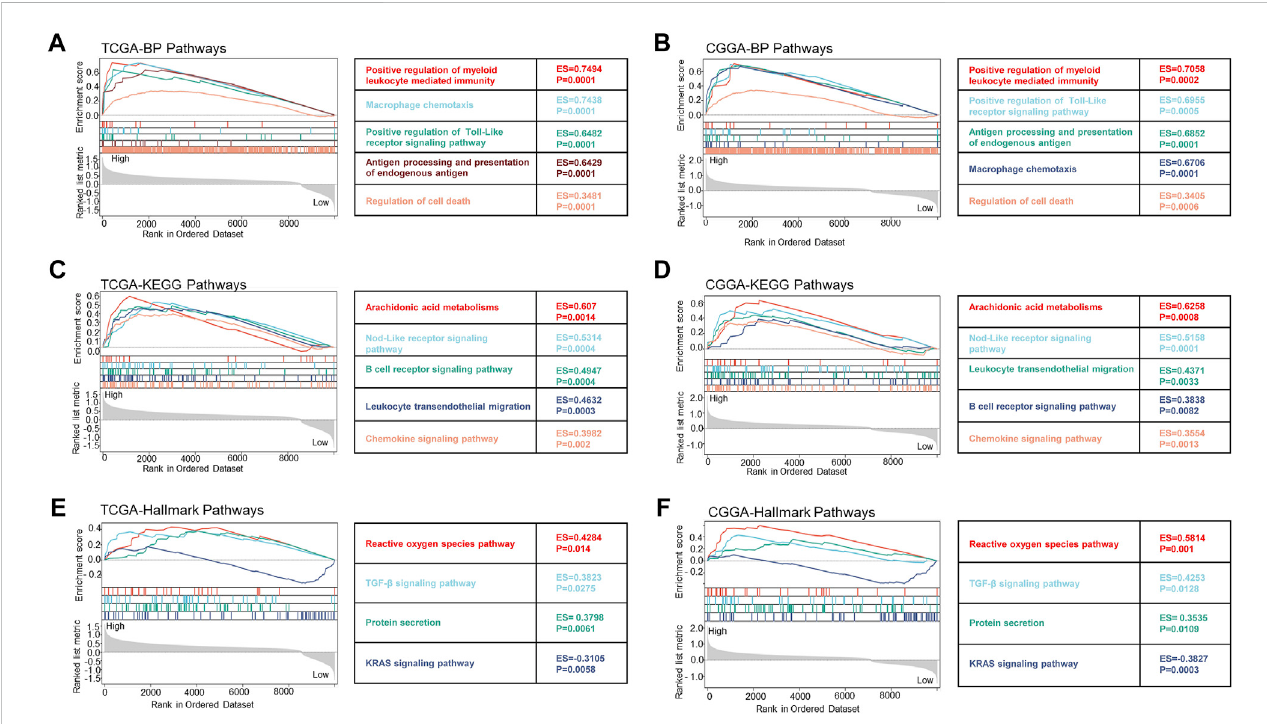
FIGURE 9 ThebiologicalfunctionofFDX1genewasshowninbiologicalprocess(BP)pathways,KEGGpathways,andHallmarkpathwaysinLGGaccordingtoTCGA and CGGA datasets. (A,B) Relationship between FDX1 expression and BP pathways. (C,D) Relationship between FDX1 expression and KEGG pathways. (E,F) Relationship between FDX1 expression and Hallmark pathways. (All analytical methods have relied on GSEA algorithm, ES, enrichment score, p < 0.05 was considered signi fi cant.)